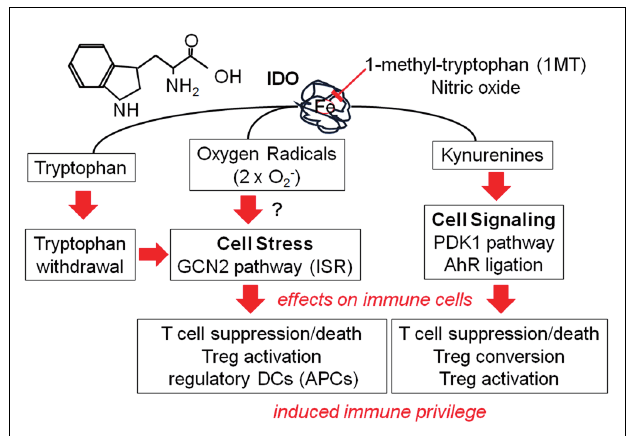
FIGURE 2 | Metabolic effects of IDO activity on immune